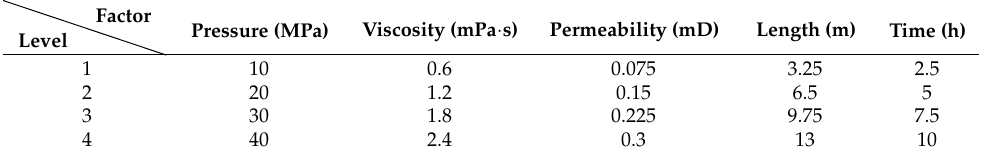
Figure 6. Example of pressure field simulation in a depletion process. ( a ) Pressure distribution (3 days), and ( b ) pressure distribution (6 days). Table 3. Influencing factors and level selection